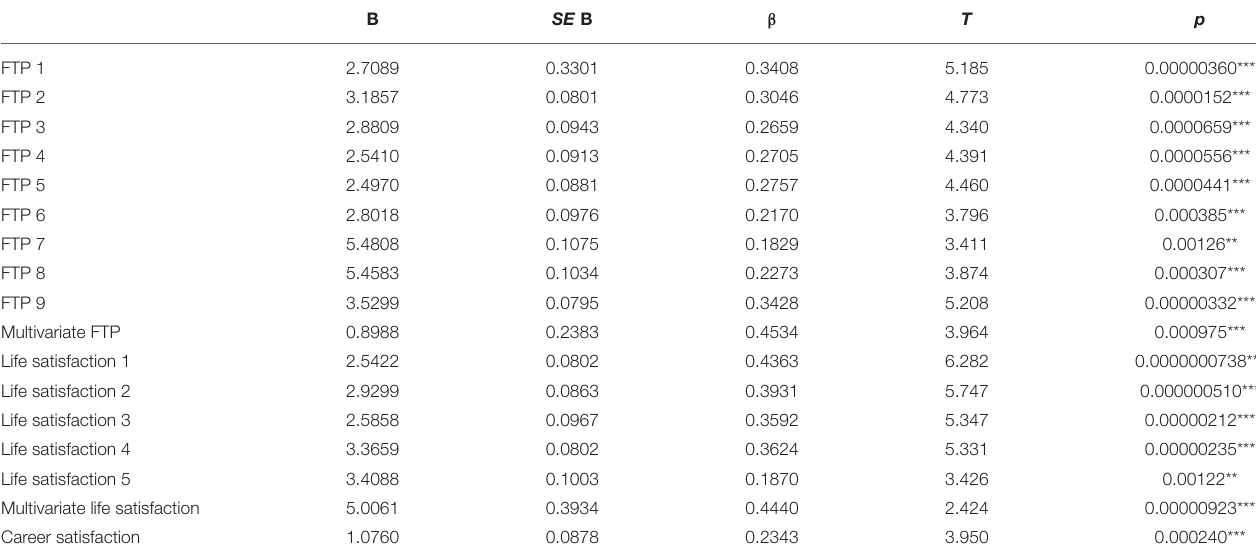
TABLE 7 | Logistic regression between the statement “I have an idea of what I will be doing musically six months from now” and measures of future time perspective (FTP), life satisfaction, and career